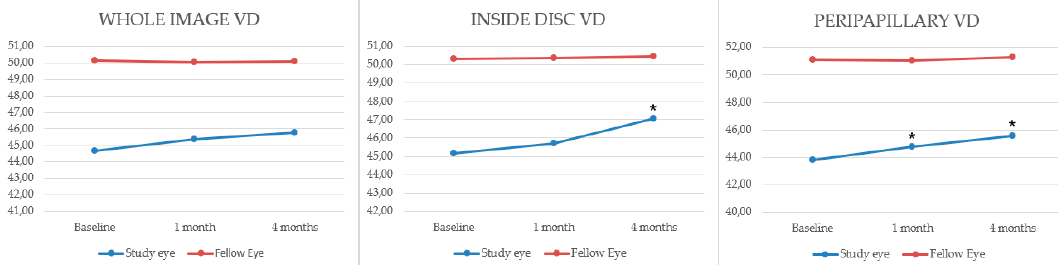
Figure 2. Comparison between the study eye (blue) and the fellow eye (red). Whole image, inside disc and peripapillary VD di ff erences (percentages) were highly statistically significant between the a ff ected eye and the fellow eye at baseline, 1- and 4-months post-treatment ( p < 0.001). In the a ff ected eyes, statistically significant parameters changes ( p < 0.05) are shown with an asterisk. Abbreviations: CRVO = central retinal vein occlusion; VD = vessel